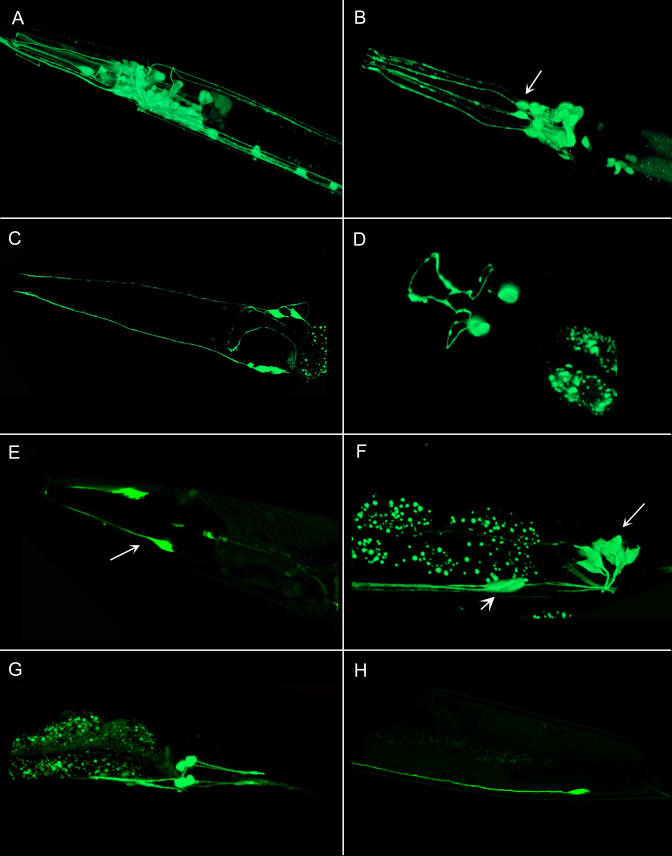
A Portrait of C. elegans Neural Tissue Expression Patterns, Driven by 5′ DNA::GFP Constructs(A) Neural network—gene B0041.7a.(B) Labial sensilla (arrow)—gene C17E4.5.(C) Amphid neuron—gene T26E3.9.(D) Ring interneuron—gene H13N06.6 (intersects with WormBase annotation).(E) Amphid socket cells (arrow)—gene Y39D8C.1.(F) Pre-anal (short arrow) and lumbar (long arrow) ganglion—gene C47A10.6 (intersects with WormBase annotation).(G) Phasmid neurons—gene W01A11.2.(H) PVT interneuron—gene M03F4.3 (intersects with WormBase annotation).